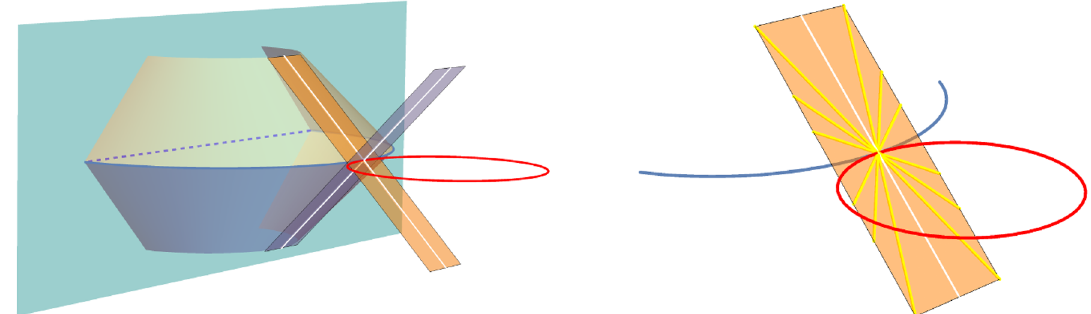
Figure 2 . A bulk curve (red) has two orthogonal lightsheets emanating from it. In the left panel, we display narrow strips of the outgoing orthogonal lightsheet (orange) and the ingoing orthogonal lightsheet (gray) in a neighborhood of a point (cid:21) , highlighting the orthogonal null rays generated by vectors n o and n i (white lines). We also show the lightsheets emanating from the tangent geodesic (blue). In the right panel, we show the NVA geodesics tangent to the outgoing lightsheet at (cid:21) . These geodesics are locally related to one another by a null rotation, which (cid:12)xes the outgoing orthogonal null vector n o . In the limit of in(cid:12)nite null rapidity, the NVA geodesics approach the outgoing orthogonal null vector n o . The unique geodesic which is NVA with respect to both lightsheets is the tangent (blue)